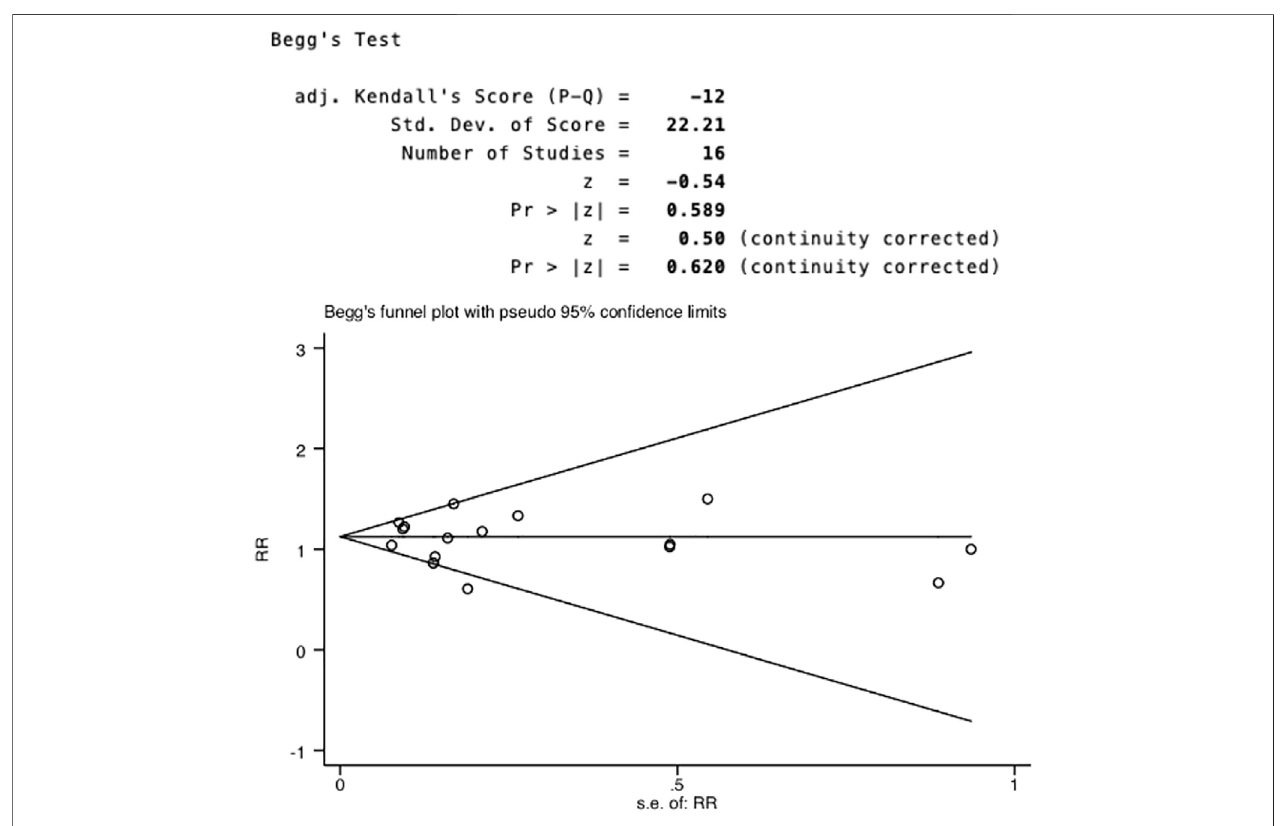
FIGURE 7 | Begg ’ s funnel plot test of publication